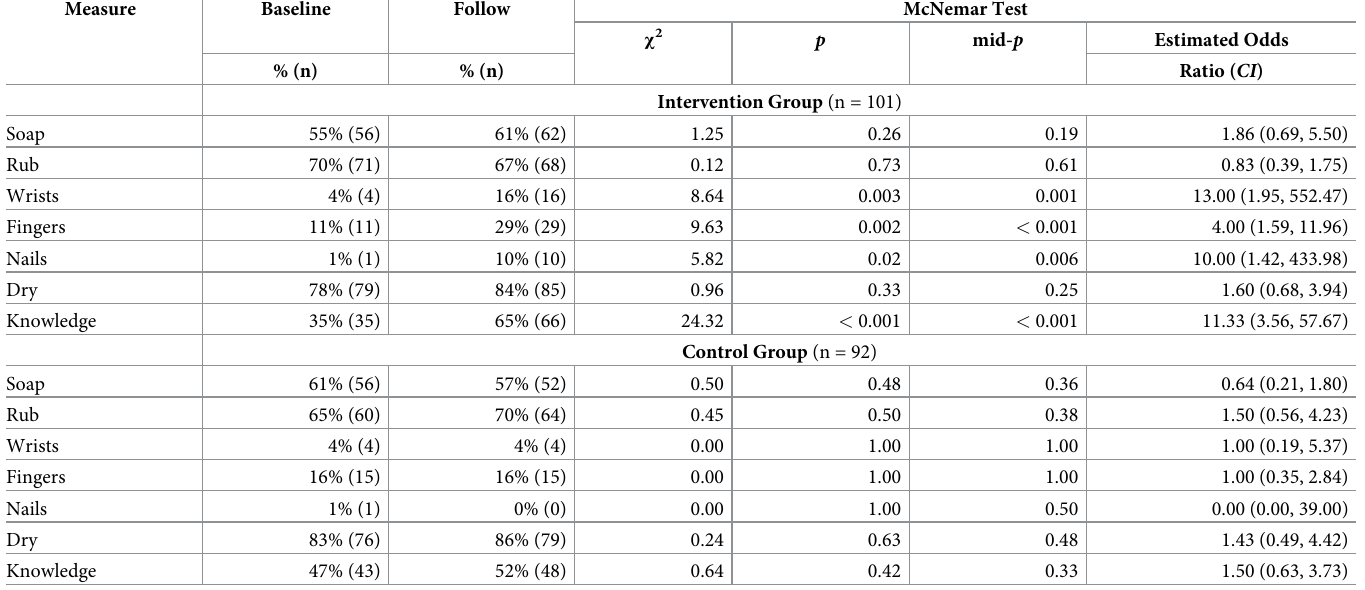
The analyses compare baseline and follow up measures within each